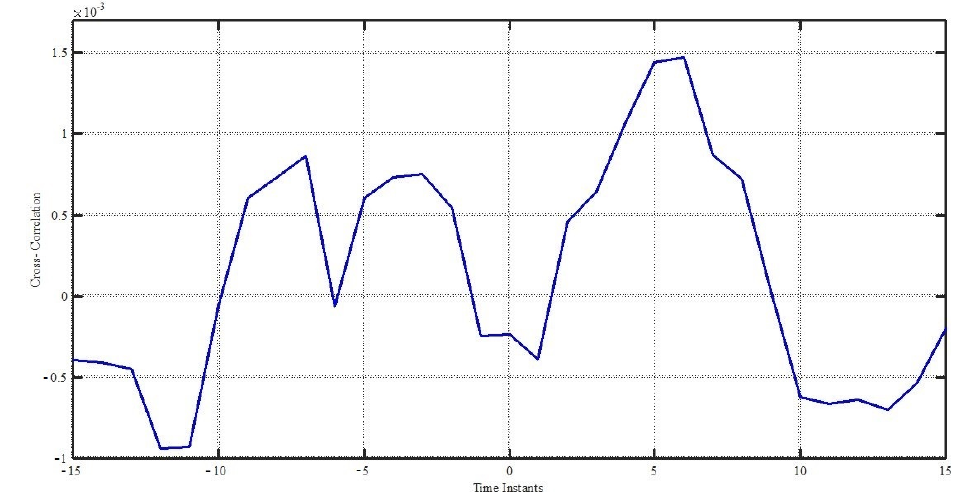
Figure 14. Cross-correlation between two electric sensors.